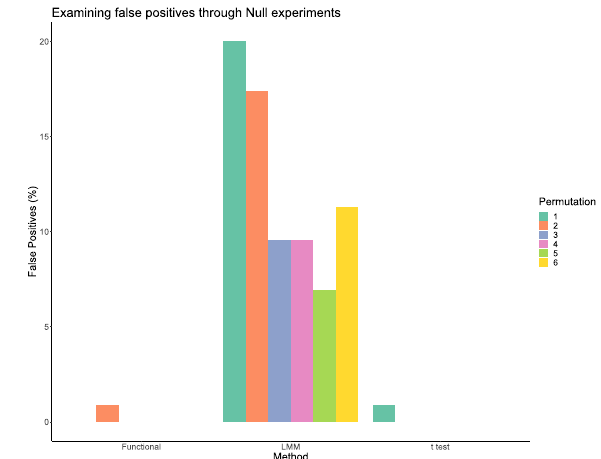
Fig. 2 Performance of statistical methods in null experiments. Our functional approach (functional), linear mixed models (LMM) and the t test ( t test) are compared in null experiments.